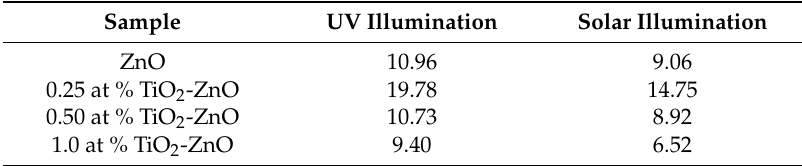
Table 5. The photocurrent density (mA/cm 2 ) (with V vs. Ag/AgCl) of ZnO, 0.25 at % TiO 2